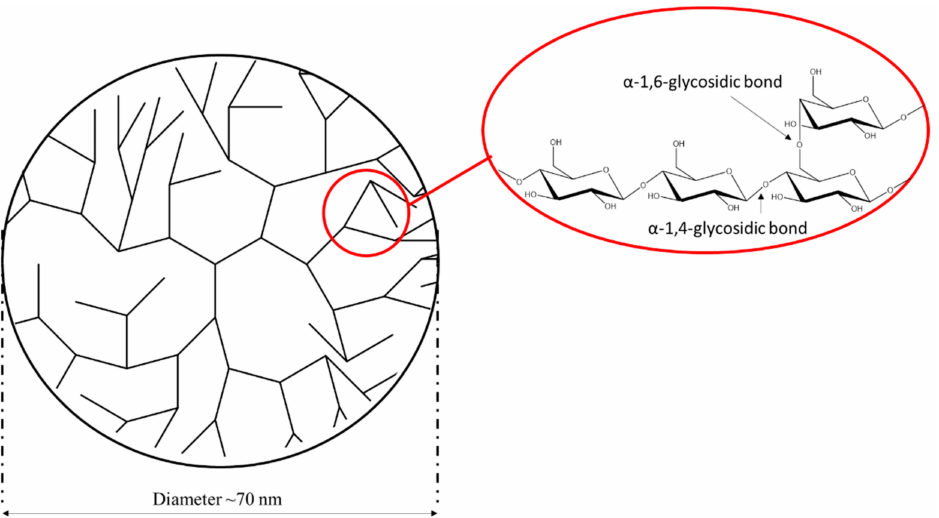
Figure 1. Schematic representation of the structure of